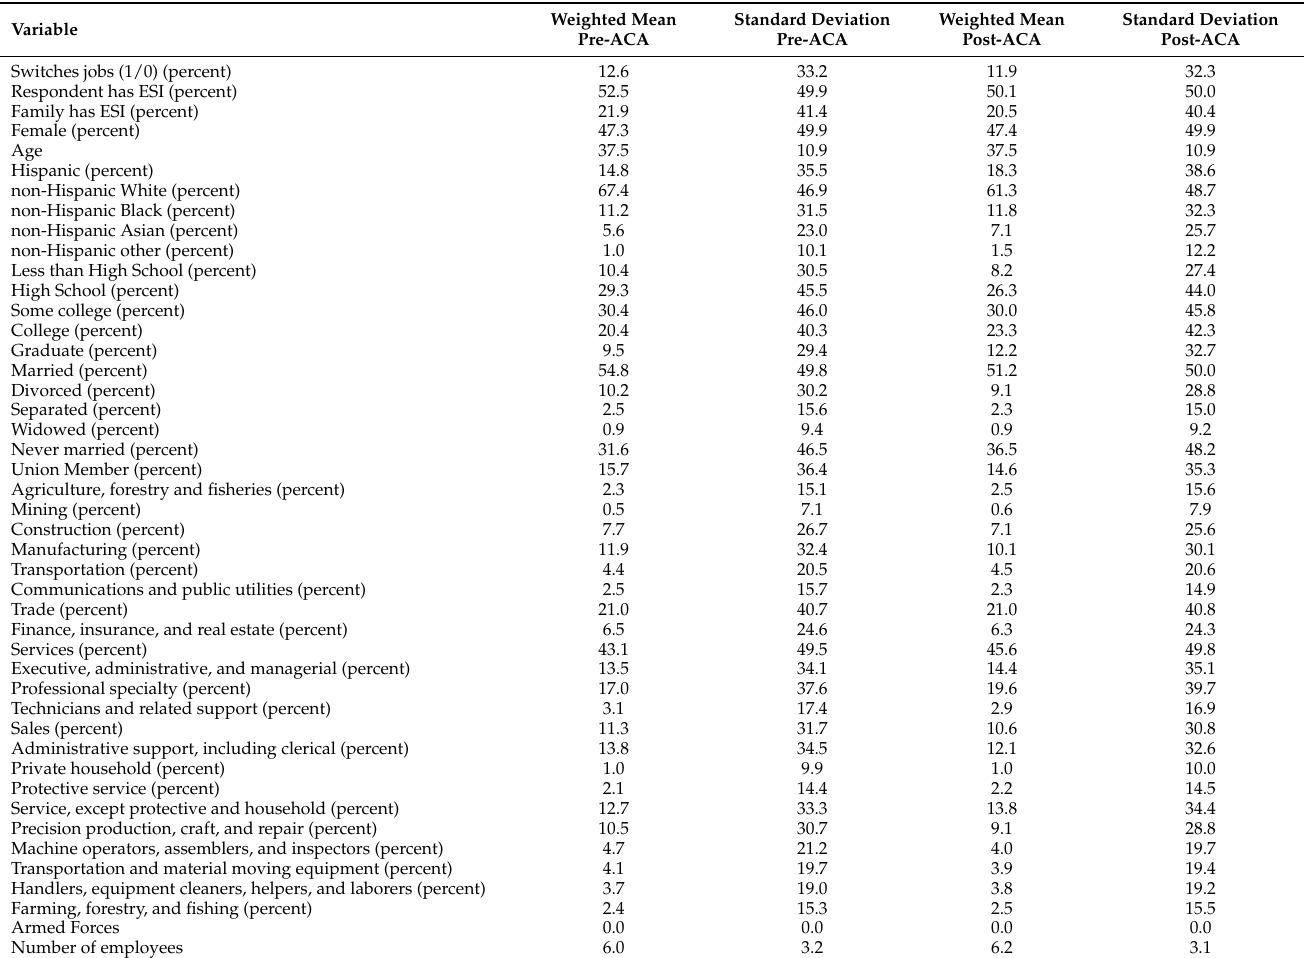
Table 2. Means and Standard Deviations Current Population Surveys ASEC: